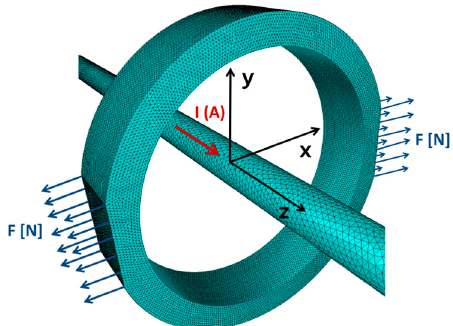
Figure 2. Simplified model of a magnetoelastic sensor in Mohri’s configuration. F–a measured force, I–a magnetizing current.